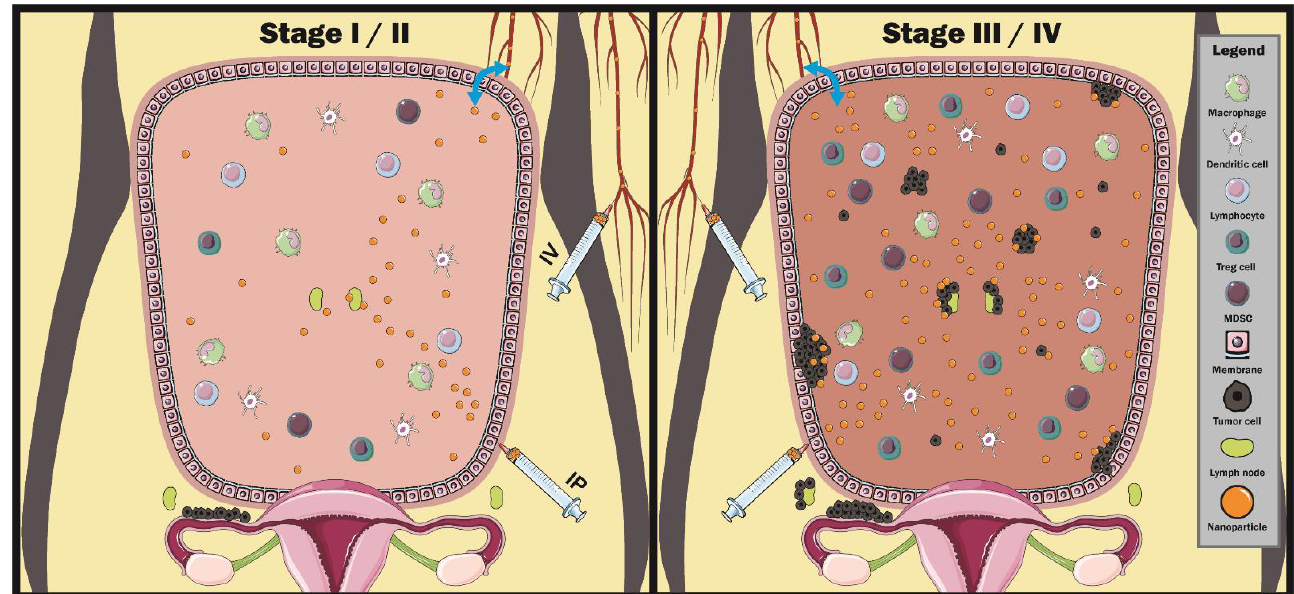
Figure 2. A schematic representation of some key factors and changes from early to late-stage ovarian cancer in terms of cellular microenvironment and nanoparticle delivery. During early stage disease, tumor cells are limited to the ovaries and immediate surroundings and have yet to spread to the peritoneal cavity, with undisrupted peritoneal homeostasis and lymphatic flow through local lymph nodes. Nanoparticles administered intravenous (IV) must circulate through peripheral blood and traverse the peritoneal membrane into the cavity (blue arrows), while intraperitoneal administered nanoparticles (IP) are delivered immediately on-site; however, administered nanoparticles are rapidly cleared via lymphatic flow. During late-stage disease, significant tumor presence in the peritoneal can severely disrupt ascites, resulting in ascites build-up, disruption of lymphatic flow and increased presence of immunosuppressive cells and factors, such as regulatory T-cells (Treg cells) and myeloid derived suppressor cells (MDSCs). This disruption of homeostasis will likely impact nanoparticle biodistribution and clearance from the peritoneal; however, this has yet to be well studied in the literature.